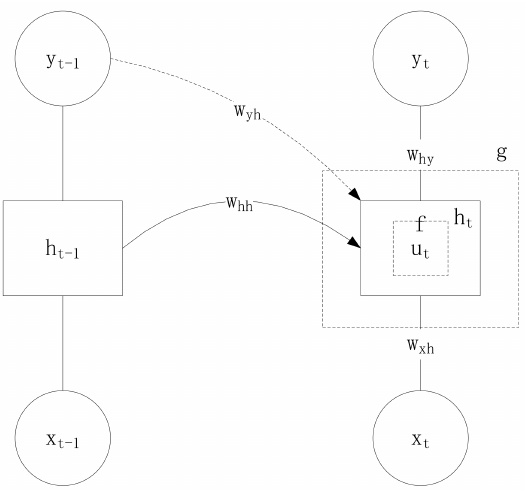
Figure 2. A diagram of the operational principle RNN’s forward propagation.